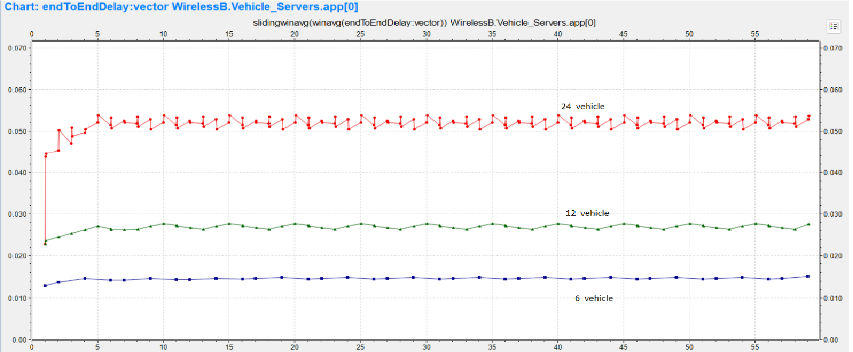
Figure 21. End-to-end delay for 6, 12, and 24